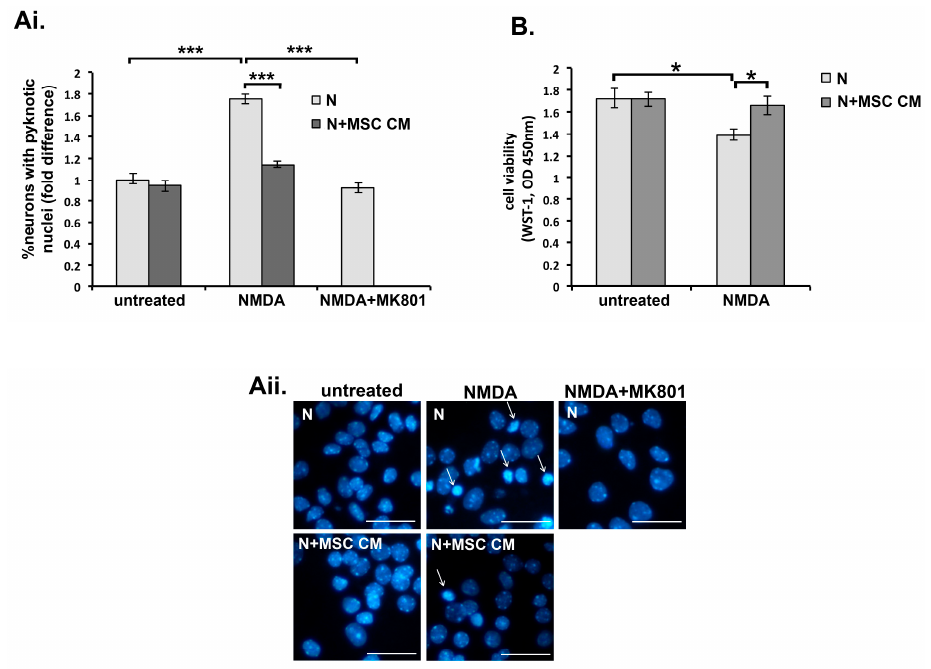
Figure 1. Mesenchymal stem cell (MSC) secreted factors protect cortical neurons against glutamate excitotoxicity. Day 9 in vivo (DIV 9) neurons (N) were pre-treated with medium alone or MSC conditioned medium (MSC CM) (24 h), then left untreated or challenged with glutamate N -Methyl- D -aspartic acid (NMDA) (50 μ M) supplemented with glycine (10 μ M) (24 h), and death was measured at DIV 11 by Hoechst staining ( A ) or the water soluble tetrazolium salt-1 (WST-1) assay ( B ). ( A ) NMDA induced neuronal death, as measured by fold increases in proportions of cells with pyknotic nuclei compared to those in untreated neurons ( i and ii , arrows show pyknotic nuclei). NMDA death was inhibited by pre-treatment of neurons with MSC CM or by presence of 5-Methyl-10,11-dihydro-5H-dibenzo(a,d)cyclohepten-5,10-imine (MK801) (10 μ M), a specific NMDA antagonist ( Ai and ii ). Neuron death is represented as fold differences compared to measurements in untreated cultures ( Ai ) . Representative fields from each culture are shown in the photographs ( Aii ). ( B ) NMDA induced neuronal death, as measured by decreased activity of mitochondrial dehydrogenase using the WST-1 assay, is inhibited by pre-treatment of neurons with MSC CM. Scale bars 50 μ M. Results shown are means ± SEM of triplicate samples from one representative of three independent experiments. * p < 0.05, *** p < 0.001, for pairwise comparisons by Student’s t -test.